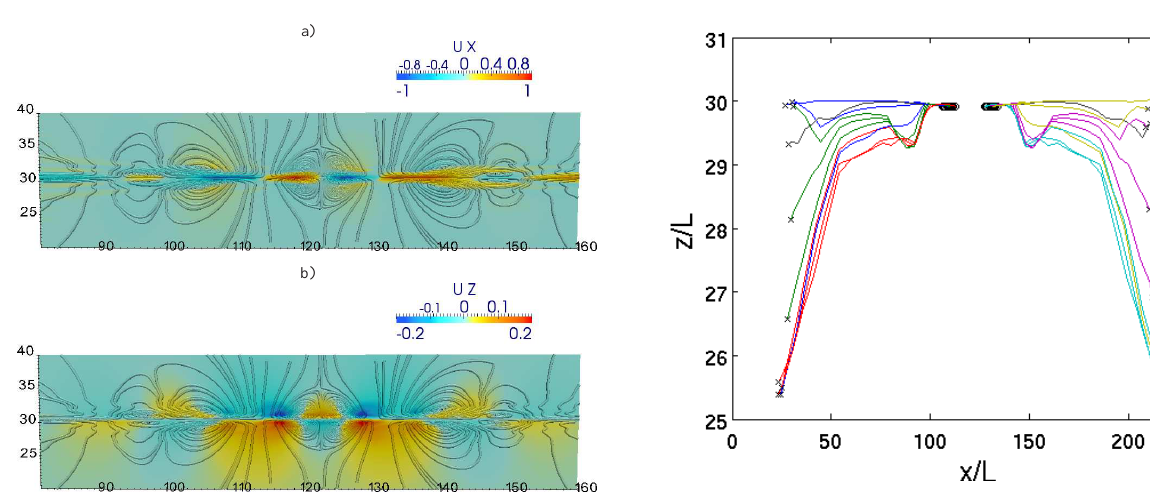
Fig. 7. Flow pattern at time t/τ A = 375 . 5. The outflow component U x is shown in panel a and the inflow component z in panel b. Blow up of the central region, the full box is 240 × 60.